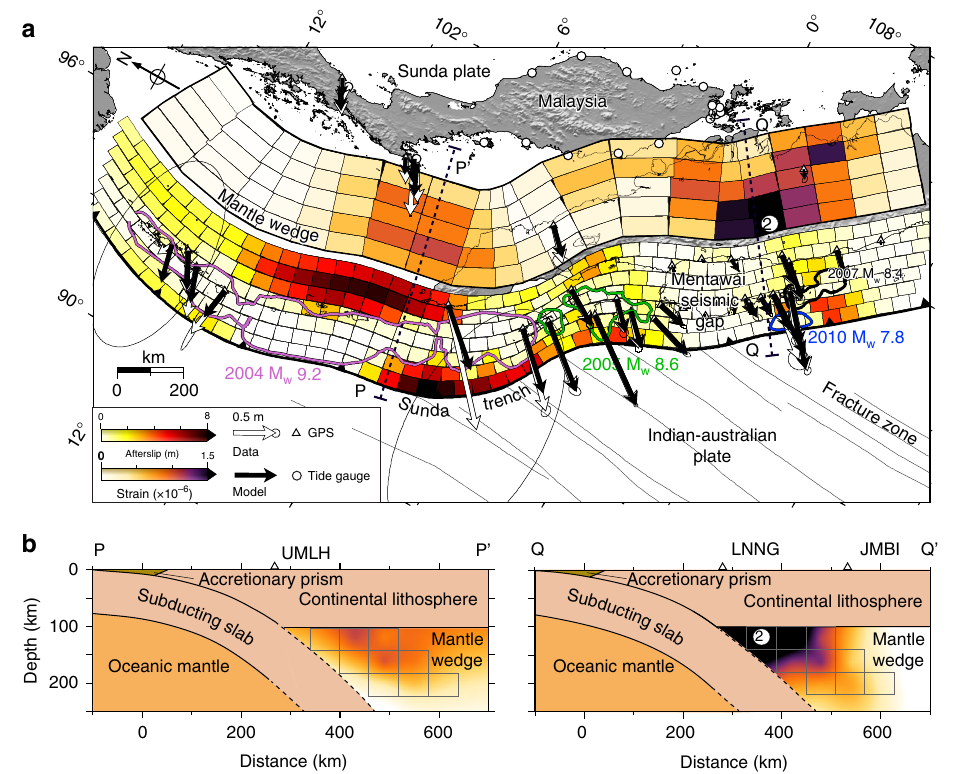
Fig. 3 Cumulative afterslip surrounding the coseismic rupture areas and the second invariant of deviatoric viscous strain in the mantle wedge following these earthquakes from 2005 to 2014. a Cumulative total afterslip and the second invariant of deviatoric viscous strain for the shallowest cuboids in the mantle wedge. Coloured contours are the same as in Fig. 1a. Vectors show a comparison between predicted model displacements (black arrows) and observations (white arrows). Black dashed lines P – P ʹ and Q – Q ʹ show the locations of two cross-sections of the viscous strain estimated for the Sumatran – Andaman and Bengkulu rupture areas. b Cross-sections showing estimated viscous strain at P – P ʹ and Q – Q ʹ in a . The light grey boxes depict the ends of the